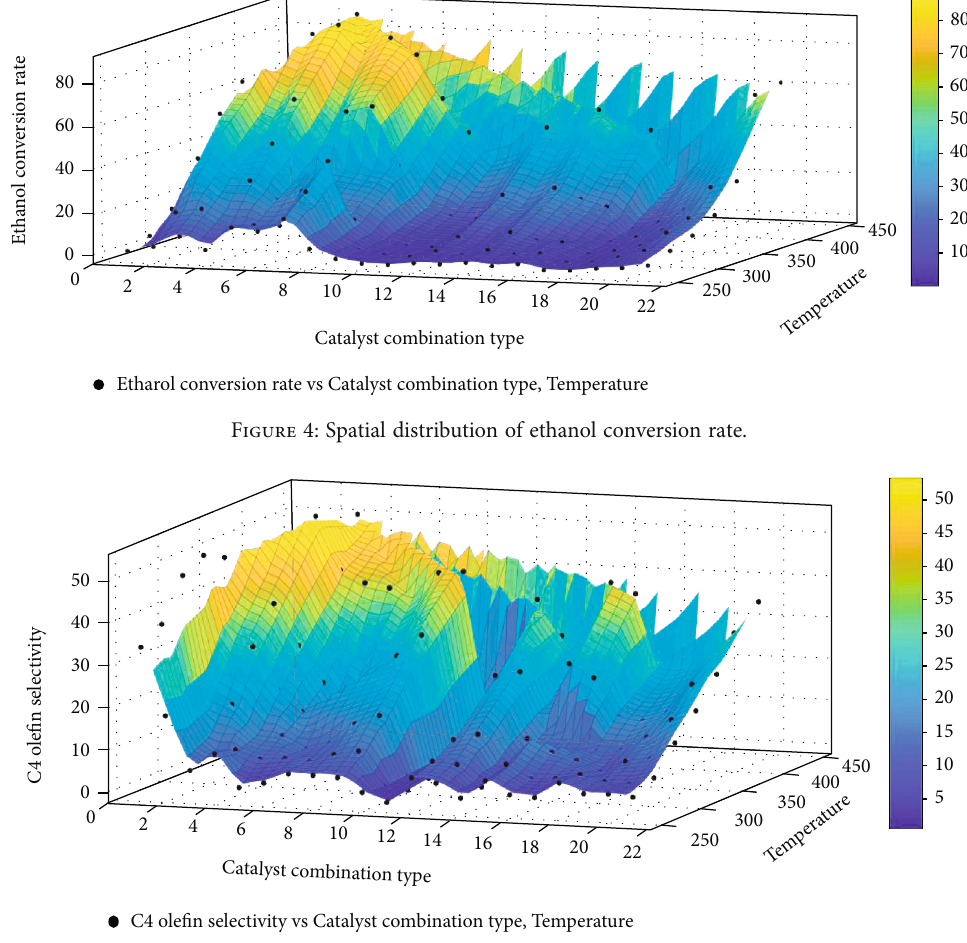
Figure 5: Spatial distribution of C